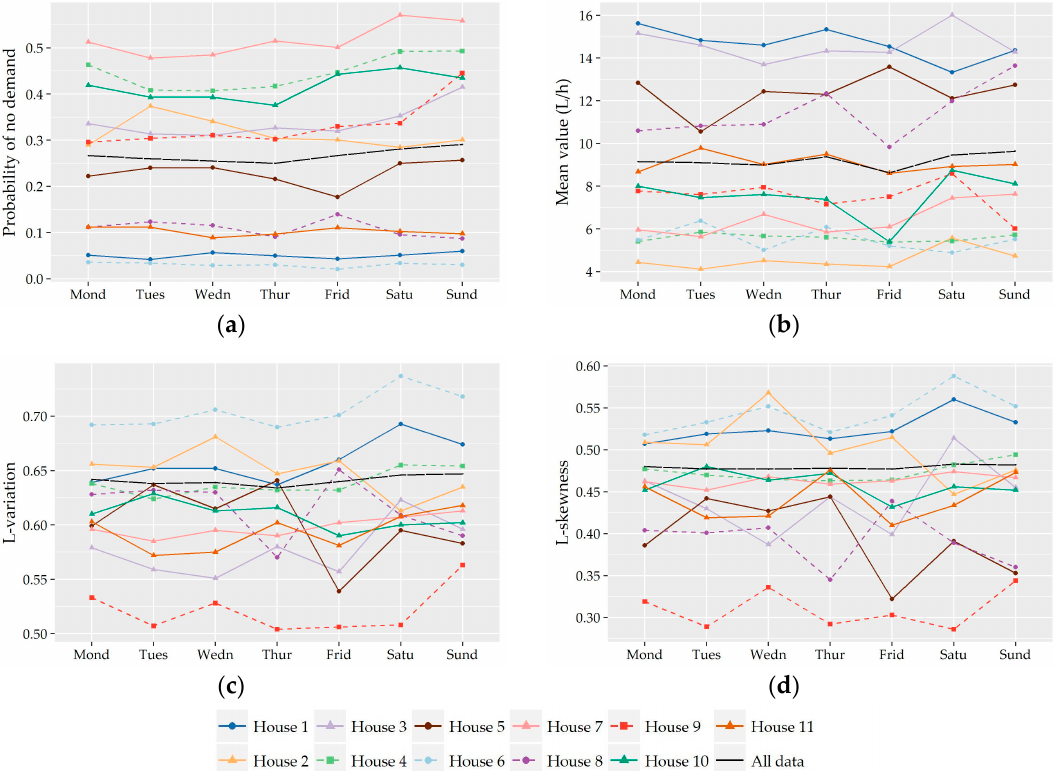
Figure A3. Hourly scale : Variation per day of the probability of no demand ( a ), mean value ( b ), L-variation ( c ), and L-skewness ( d ) of the hourly nonzero demand records.